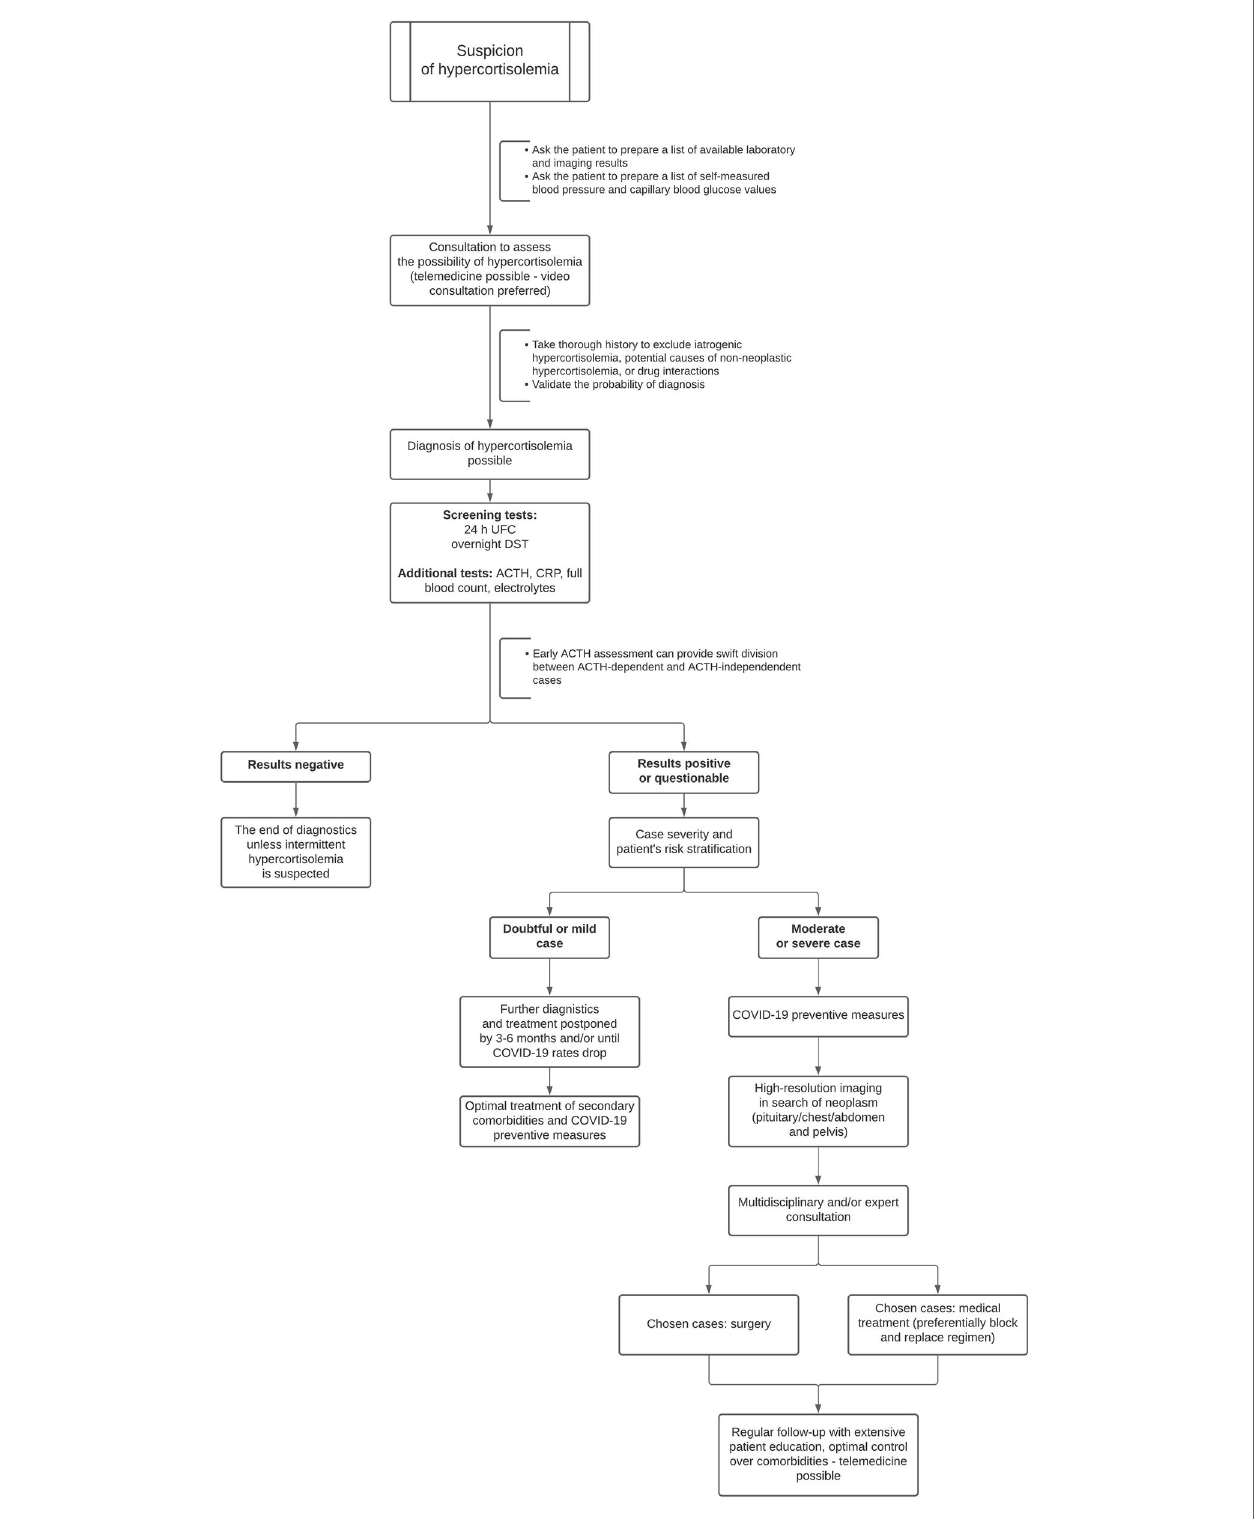
FIGURE 1 | Modi fi ed approach to assessment of newly suspected hypercortisolemia in the era of COVID-19 based on the expert guidelines. UFC, urinary free cortisol; DST, dexamethasone suppression test; ACTH, adrenocorticotropic hormone; corticotropin; CRP, C-reactive protein.